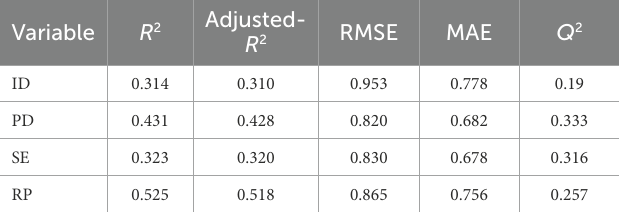
TABLE 12 Model fit evaluation.